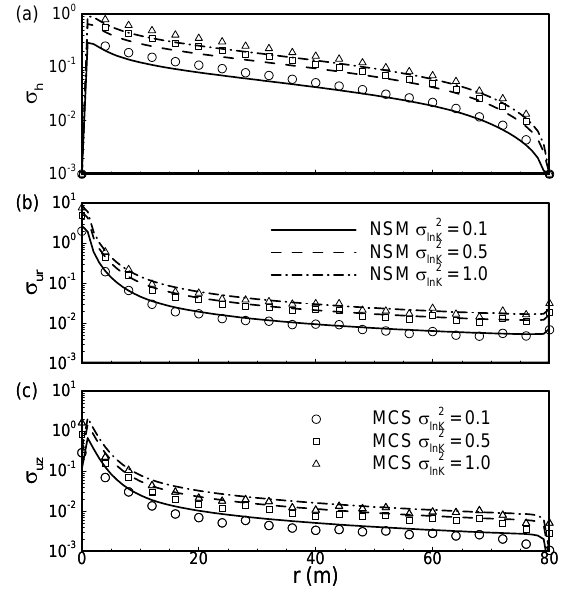
Fig. 8. The center line profiles of flow uncertainties that are obtained by using NSM (lines) and MCS (symbols) at t= 80 day for fixed r-direction correlation length of 5m and different lnK variances.